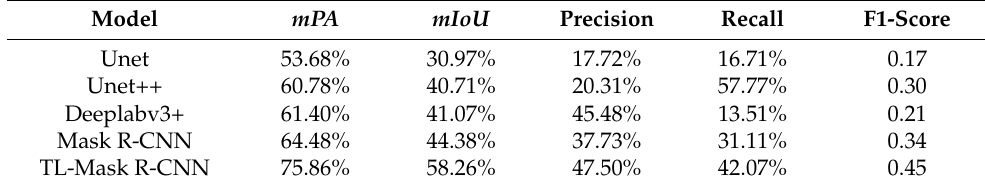
Figure 11. Old landslides detection results. ( a1 – a3 ) represents different landslides, ( b1 – b3 ) are the results of expert visual interpretation, and ( c1 – c3 ) are the results of our model. Table 2. Evaluation of old landslide detection